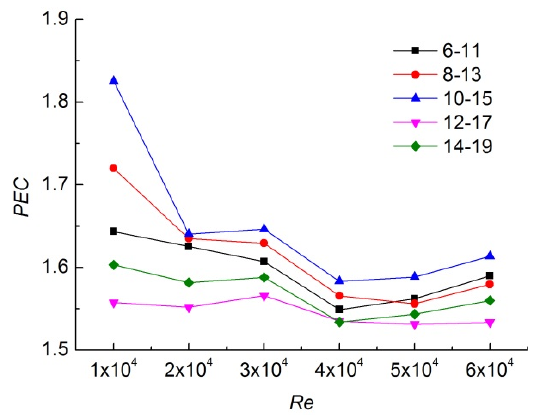
Figure 10. The variation of PEC of pipe pass with Re. Figure 11. The variation of shell side PEC with Re. Figure 11. The variation of shell side PEC with